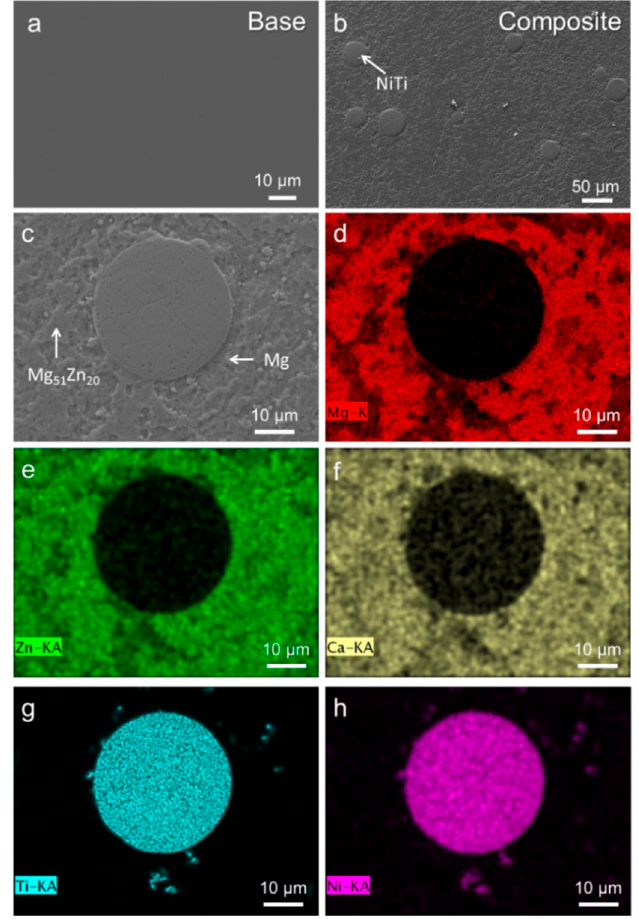
Figure 2. SEM images for ( a ) base alloy; ( b , c ) BMG composite at different magnifications; ( d – h ) EDX mapping taken from ( c ) (( d ): Mg; ( e ): Zn; ( f ): Ca; ( g ): Ti; and ( h ): Ni).